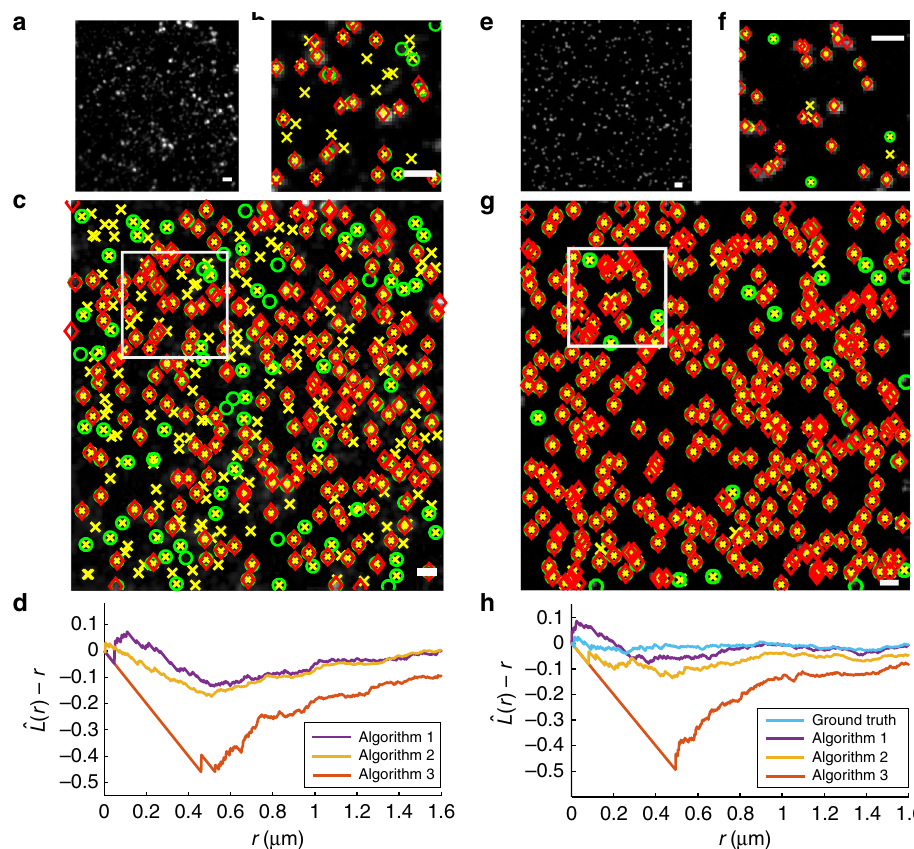
Fig. 1 Detecting the effect of algorithmic resolution. a Fluorescence microscopy image of clathrin-coated pits on the membrane of an HMEC-1 cell.